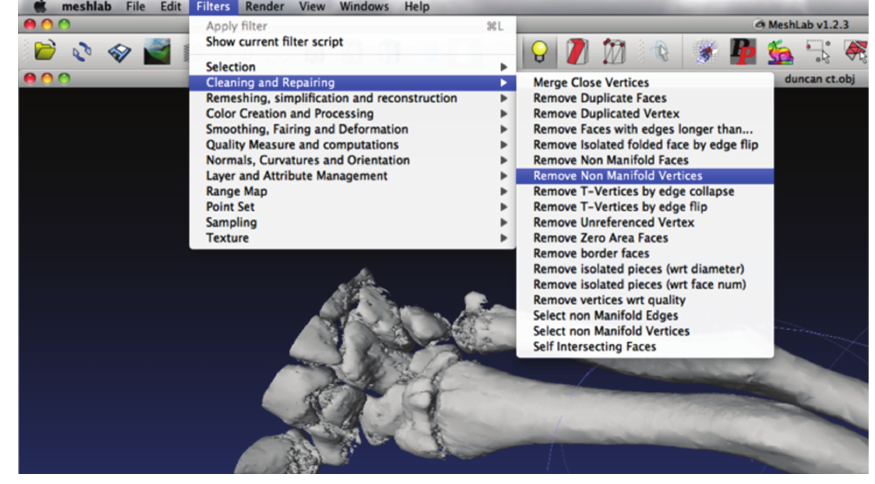
Figure 7: “Cleaning” of the mesh.